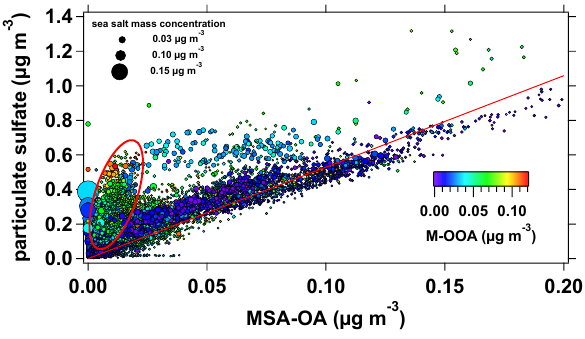
Fig. 9. Correlation between particulate sulfate and methanesulfonic acid OA mass concentration, colour-coded by the mass concentra- tion of the PMF M-OOA factor. The size of the marker represents the amount of sea salt. The red ellipse indicates a cluster of points that might be affected by long-range transport. The red line repre- sents the linear regression between particulate sulfate and MSA-OA when M-OOA<0.01µgm − 3 (slope = 5.3 ± 0.03, R 2 = 0 . 92 )